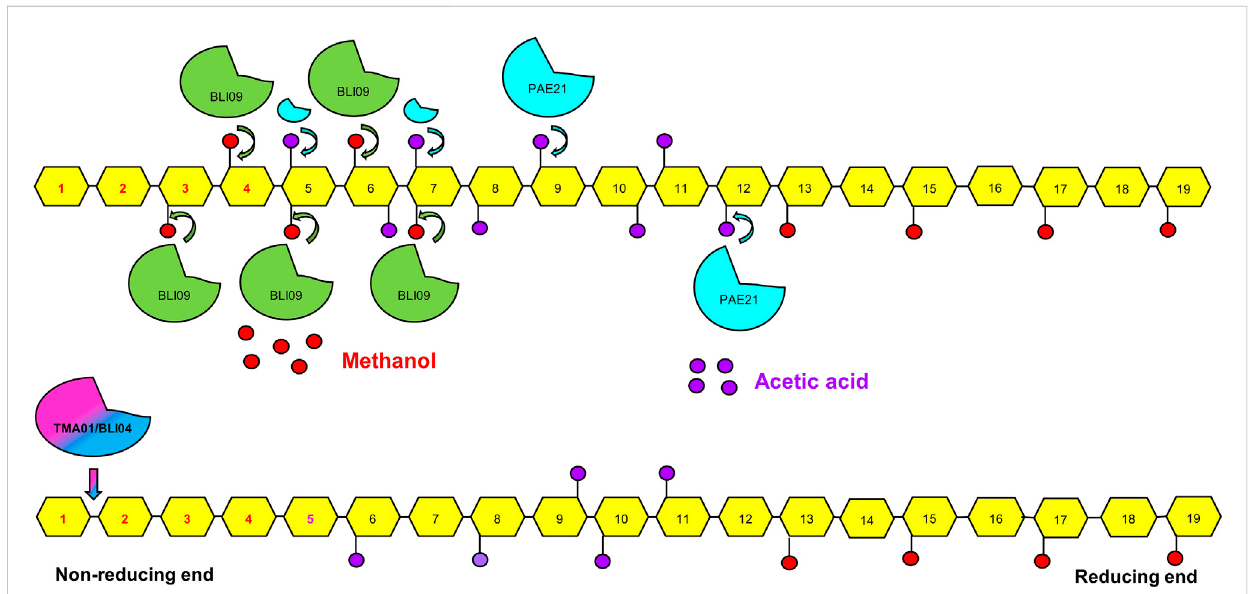
FIGURE 7 Schematicrepresentation ofthesynergistic actionbetweenBLI09PMEwith eitherTMA01 orBLI09exo-PGsalongwith PAE21 ontheHGbackbone in sugar beet pectin. The blockwise demethylation pattern of BLI09, the blockwise distribution of acetyl groups and the deacetylation of PAE21 at O-3 positions of non-methylated GalA suggesting a random deacetylation pattern are illustrated. In addition, the exo-PGs action in the non-reducing end of demethylated and deacetylated pectin leading to monomeric GalA release is presented. No major increase in GalA release was observed with the addition of PAE21 into the synergistic reactions. GalA monomers highlighted in red (from 1 to 4) can be released by BLI09 with either TMA01 or BLI04. While the additional GalA monomer highlighted in purple (number 5) can be released with the addition of PAE21. ( ) GalA, ( ) methyl groups and ( ) acetyl groups. PME: pectin methylesterase, exo-PG: exo-polygalacturonase, PAE: pectin acetylesterase, HG: homogalacturonan and GalA: galacturonic